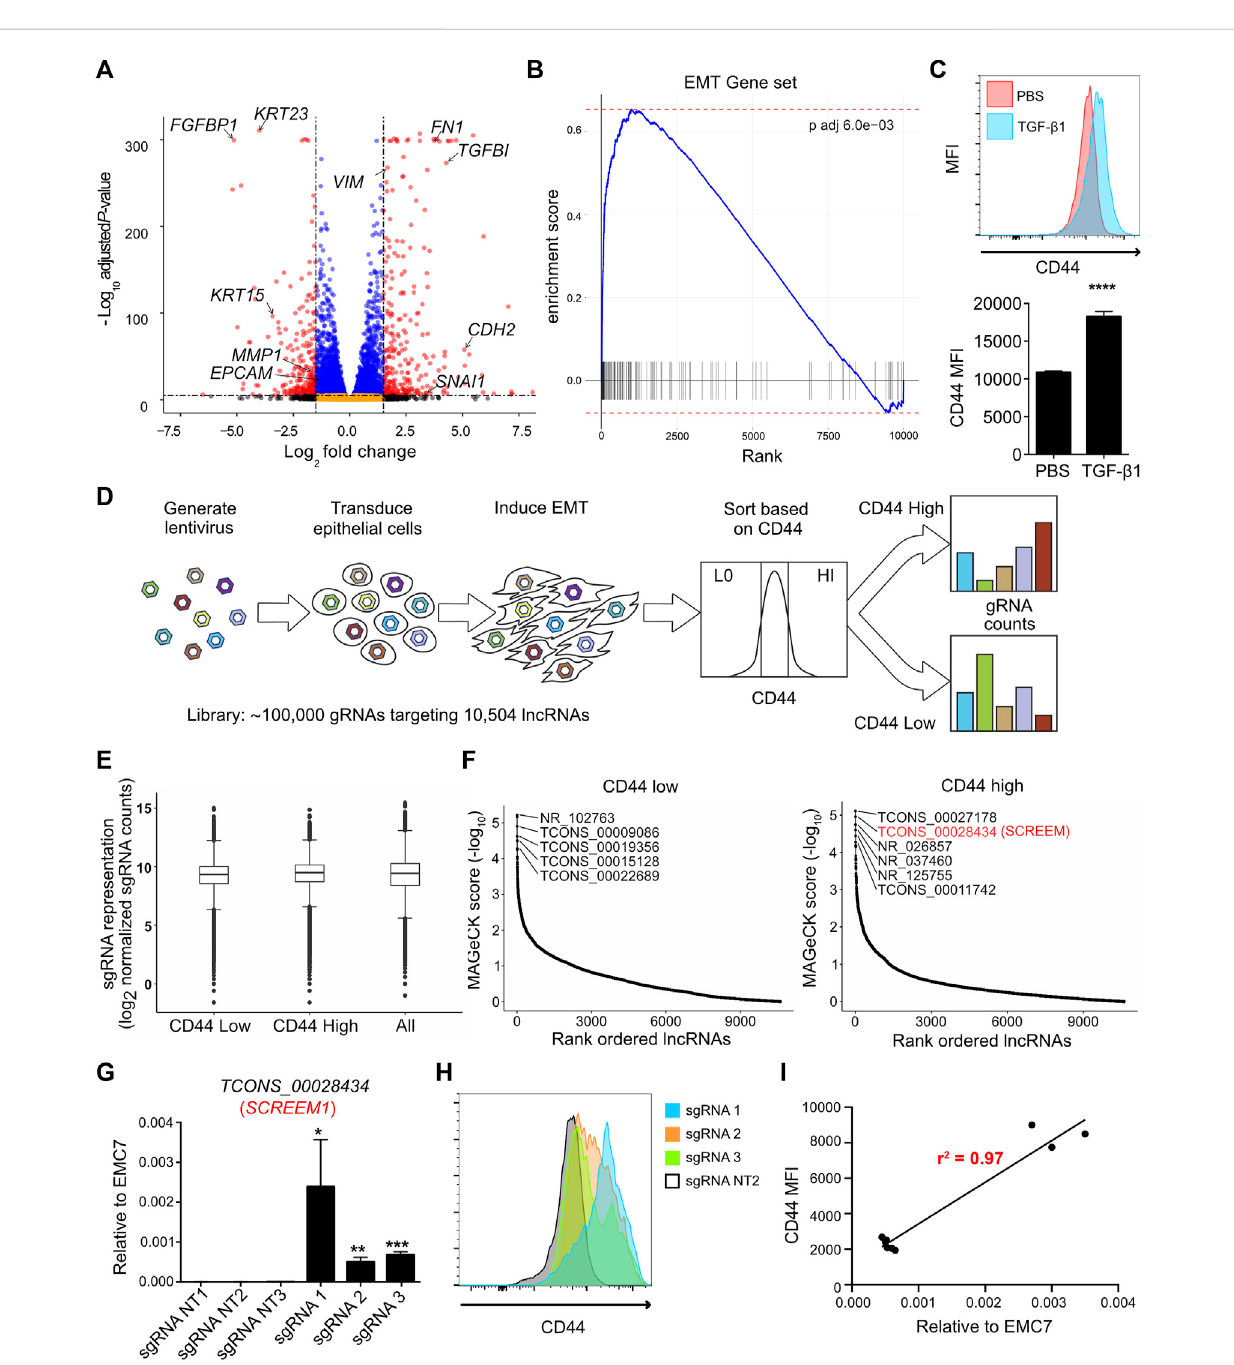
CRISPRascreenidenti fi esfunctionalcandidatelncRNAloci. (A) Volcanoplotofexpressedgenes(TPM ≥ 1)betweenPBSandTGFB1(10ng/ml)treated HBEC3-KTcells, n=3.Reddots,adjusted p -value < 10 – 6 andlog2 foldchange > 2;bluedots, adjusted p -value < 10 – 6 andlog2foldchange < 2;blackdots, adjusted p -value > 10 – 6 and log2 fold change > 2; orange dots, > 10 – 6 and log2 fold change < 2. (B) Ranked ordered gene set enrichment analysis of differentially expressed genes between PBS and TGFB1 (10ng/ul) treated HBEC3-KT cells, n = 3. The EMT pathway is shown. (C) Top panel - fl ow cytometric analysis of cell surface marker expression using CD44 staining, comparing HBEC3-KT cells treated with TGF β 1 (10 ng/ul) or PBS for 72 hrs. Bottom panel - graphs representing fl ow cytometric results for each replicate. Mean fl uorescence intensity (MFI) of CD44 staining is shown. Error Bars, mean ± SD; n = 3. Stats, unpaired t -test; **** p < 0.0001 (D) Schematic of CRISPRa screen strategy. Cas9 synergistic activation mediator (SAM) based CRISPR activation (CRISPRa) screen; where, 10,504 intergenic lncRNA loci were targeted using a single guide RNA (sgRNA) library (with ~10 sgRNAs per TSS). Cell surface receptor CD44 was used as a marker to differentiate between epithelial-like (CD44-low) and mesenchymal-like states (CD44-high) after EMT induction using TGF β 1. FACS was used to sort the top 10% high and 10% low the cells based on CD44 expression. (E) Box and whisker plot showing sgRNA frequencies before fl ow sort (all) and after fl ow sort (CD44 low and CD44 high). Plotted mean counts from n = 3. (F) Ranked ordered dot plot of MAGeCK p values( − log 10 ) for the CD44 low (left) and CD44 high (right). (G) RT-PCR analysis SCREEM1 expression relative to EMC7 in HBEC3-KT cells upon CRISPR-activation of the SCREEM1 locus with three different sgRNAs. NT, non-targeting. All values are mean ± SD with n = 3 per sgRNA; unpaired t -test with Welch ’ s correction; * p < 0.05; ** p < 0.01; *** p < 0.001. (H) Flow cytometric analysis of CD44 expression in HBEC3-KT cells upon CRISPR-activation of the SCREEM1 locus with different sgRNAs. (I) Correlation between relative levels of SCREEM1 (RT-PCR, panel (G) and surface levels of CD44 ( fl ow cytometry, panel H) following activation of the SCREEM1 locus. Statistics, simple linear